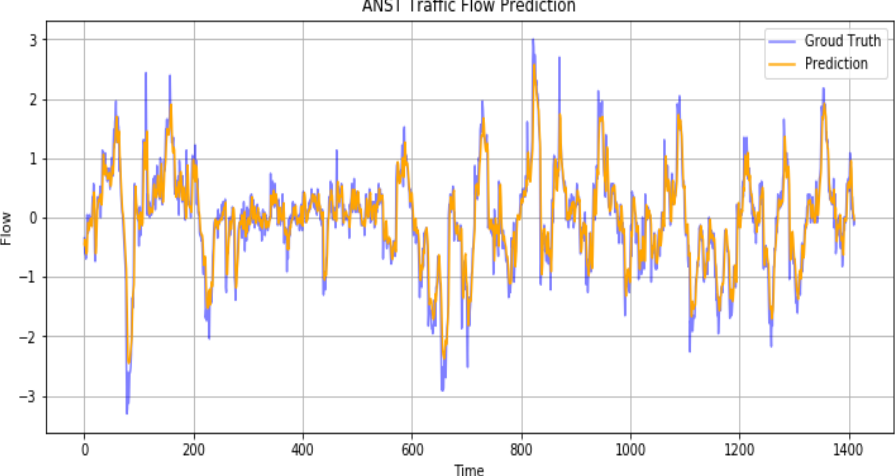
Figure 7. ANST ground truth and